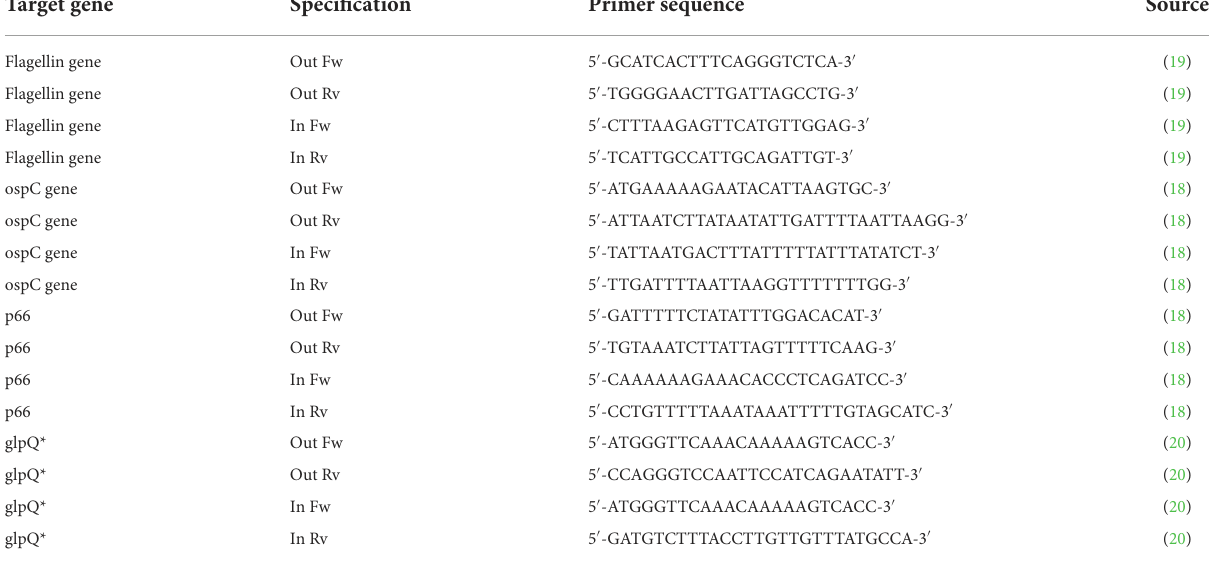
TABLE 2 Selected primers used for Borrelia detection.